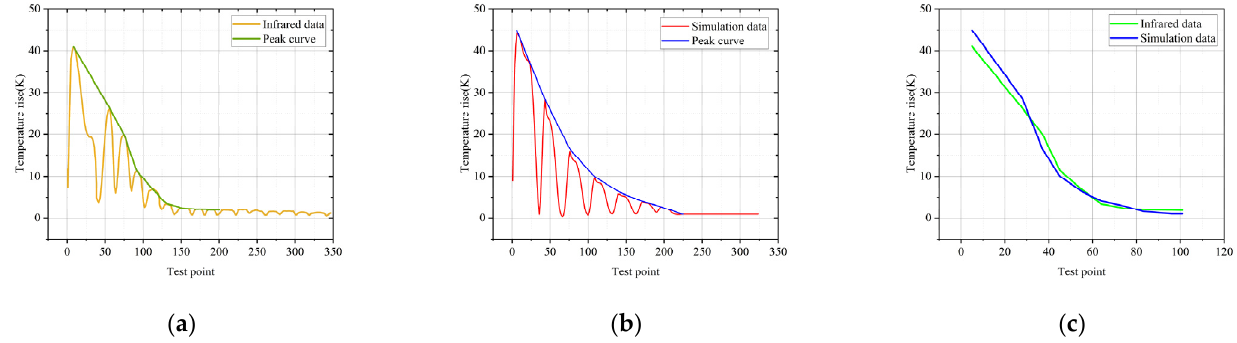
Figure 10. ( a ) Infrared temperature-rise curve of #1; ( b ) simulated temperature-rise curve of #1; ( c ) peak curve comparison diagram of #1.